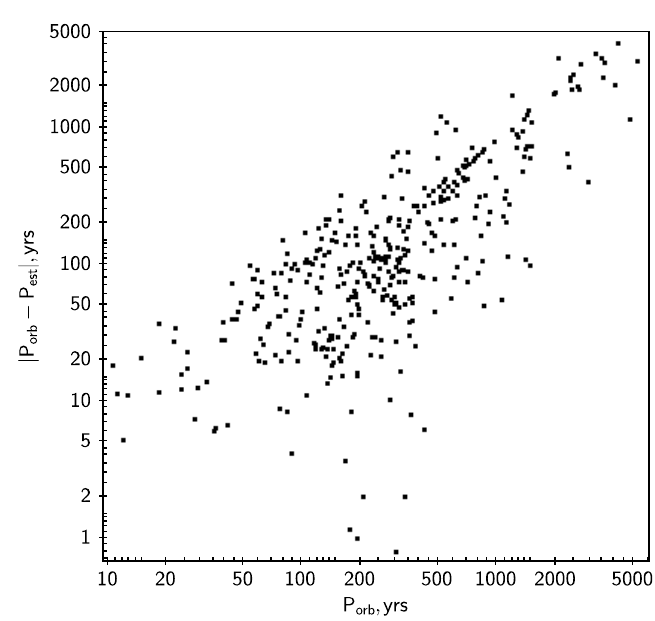
Fig. 2. The difference between the orbital and estimated periods for the same binaries vs. orbital period (based on the data for 833 binaries with orbital periods ≥ 10 yrs found both in the refined WCT dataset and in the ORB6